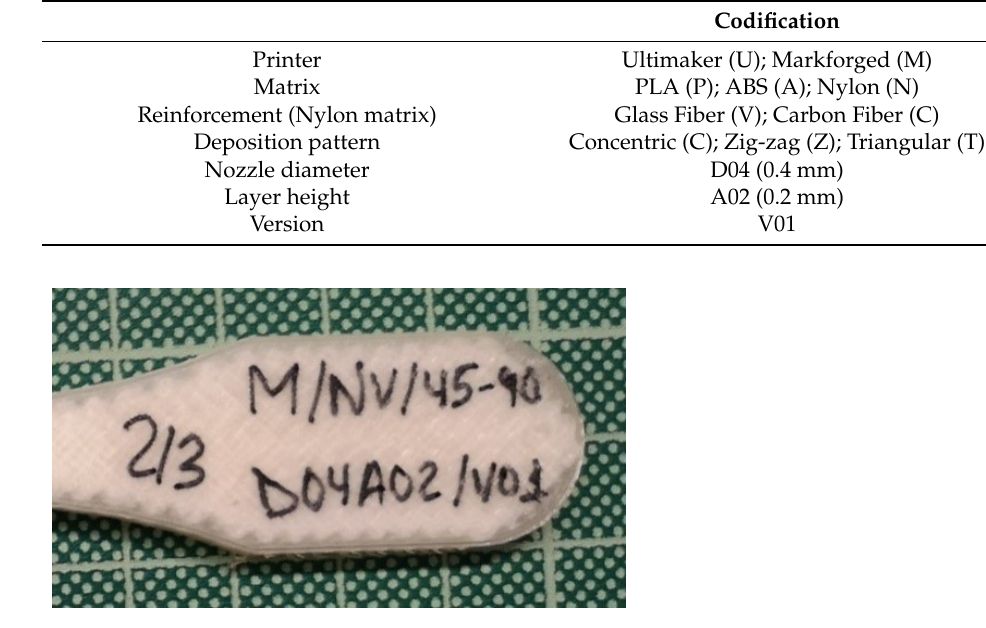
Figure 6. Samples codification.